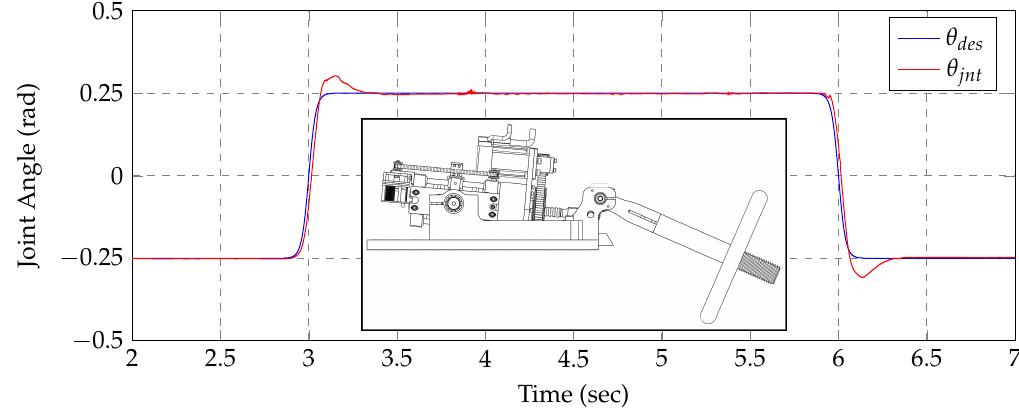
Figure 11. High speed joint position tracking with 2.26 kg load located at 0.2 m from the